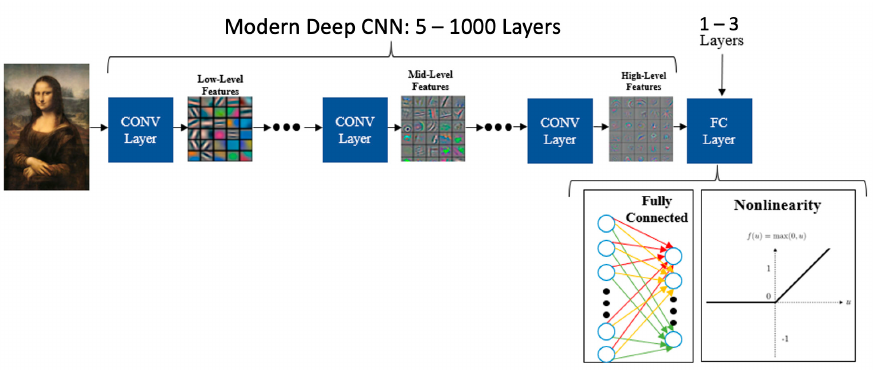
Figure 1. Convolutional Neural